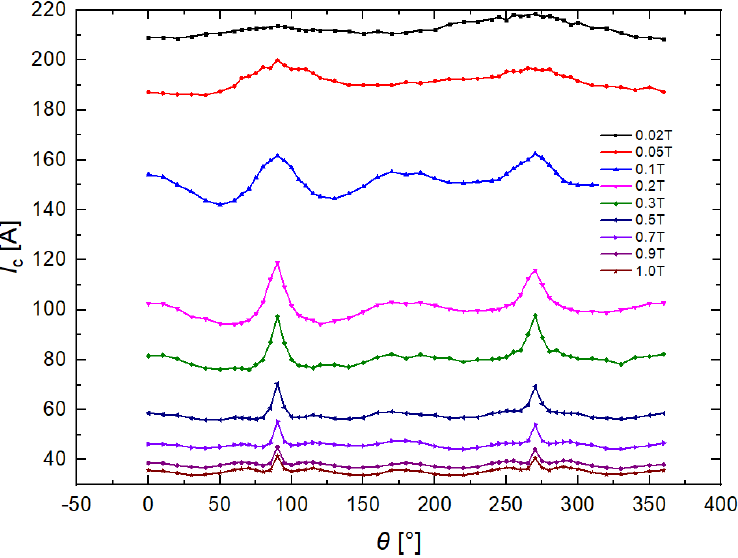
Figure 11. The I c − B − θ characteristics of the tapes winding the DP module at 77 K.